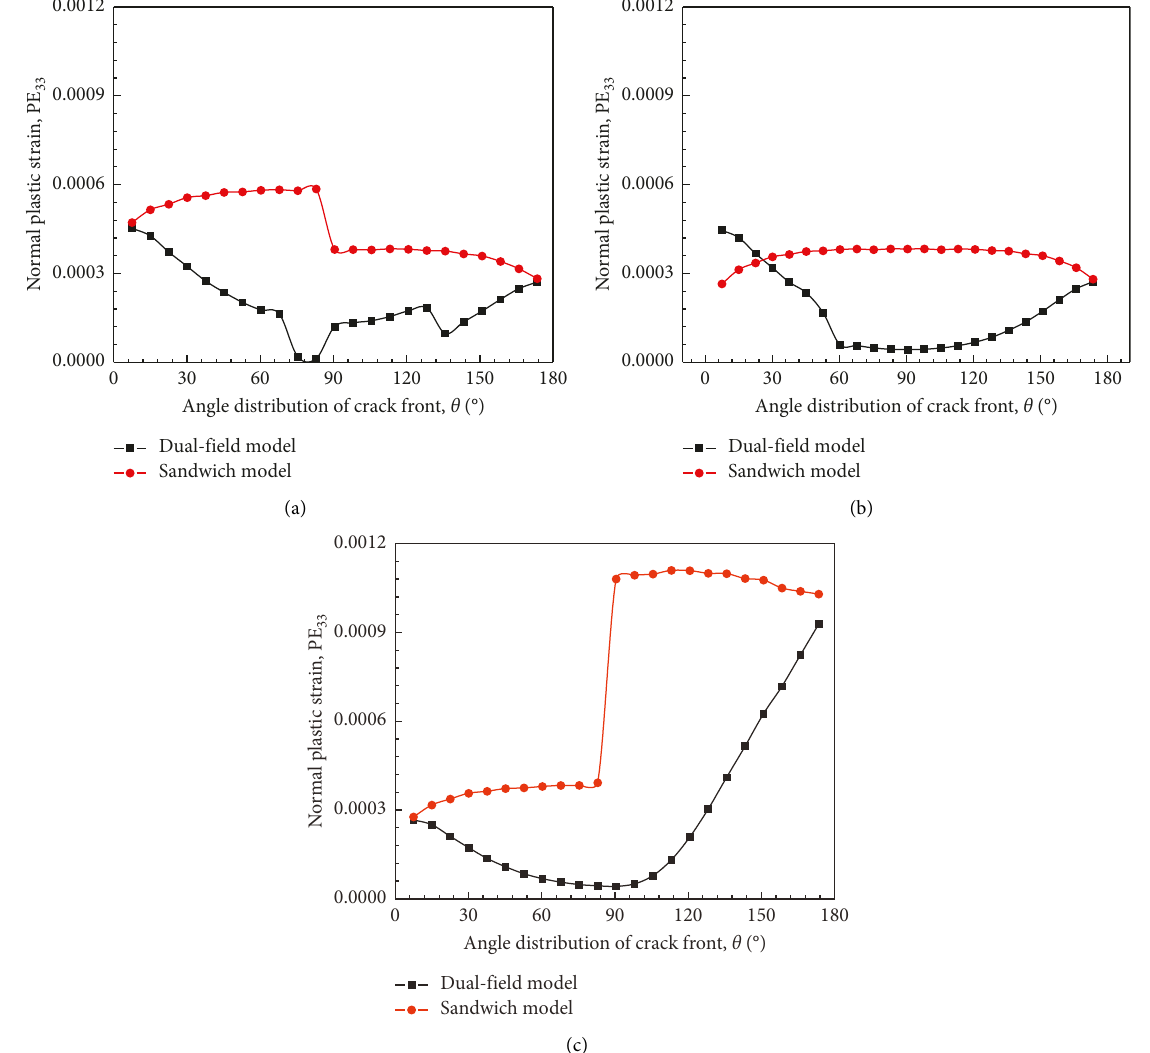
Figure 10: Distribution of normal plastic strain along crack front with crack angle. (a) Crack-10. (b) Crack-1. (c)